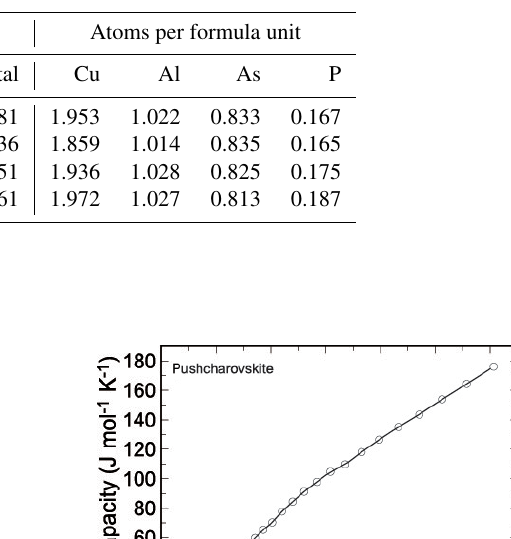
Table 6. Electron microprobe analysis of liroconite.